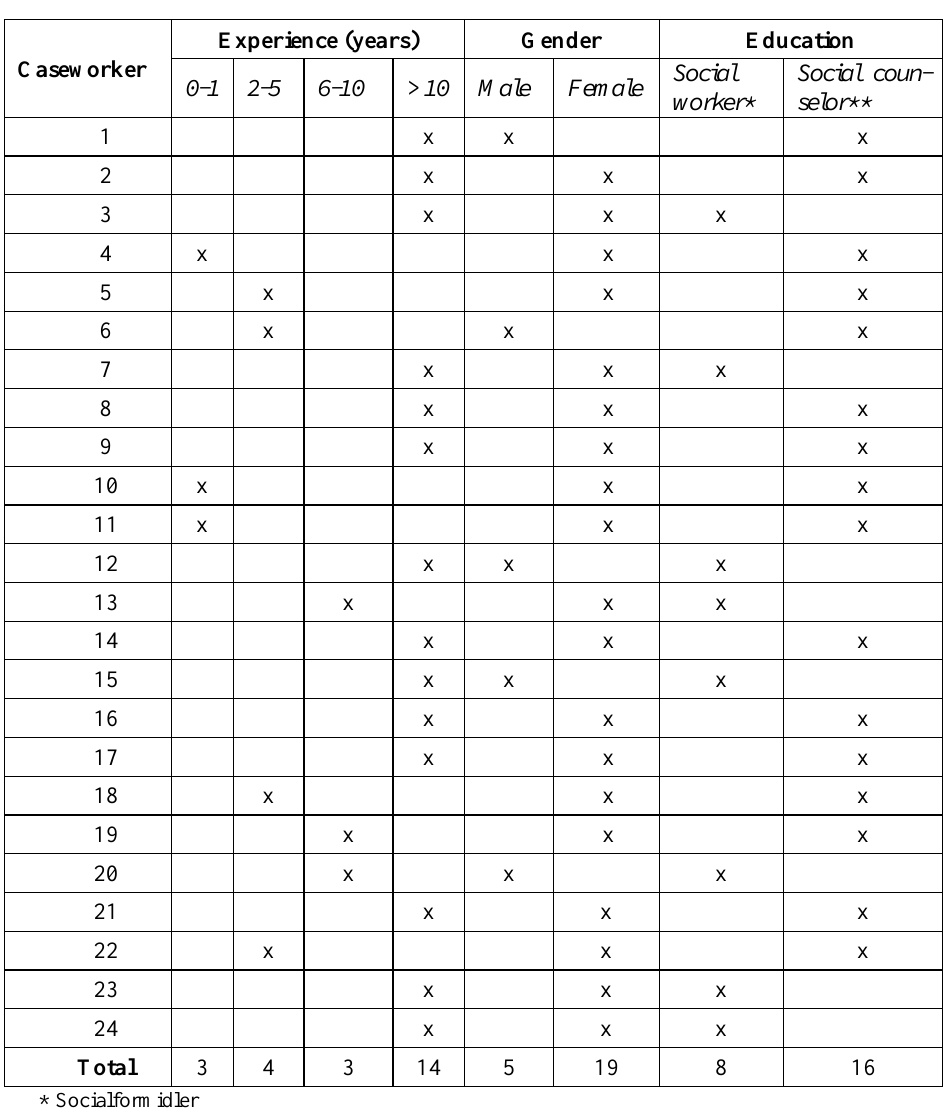
Caseworker characteristics